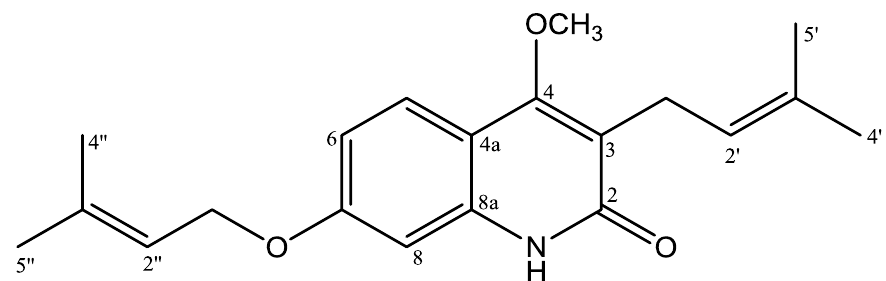
Figure 1. Structures of 4-methoxy-3-(3-methylbut-2-en-1-yl)-7-[(3-methylbut-2-en-1-yl)oxy]quinolin- 2(1 H )-one.